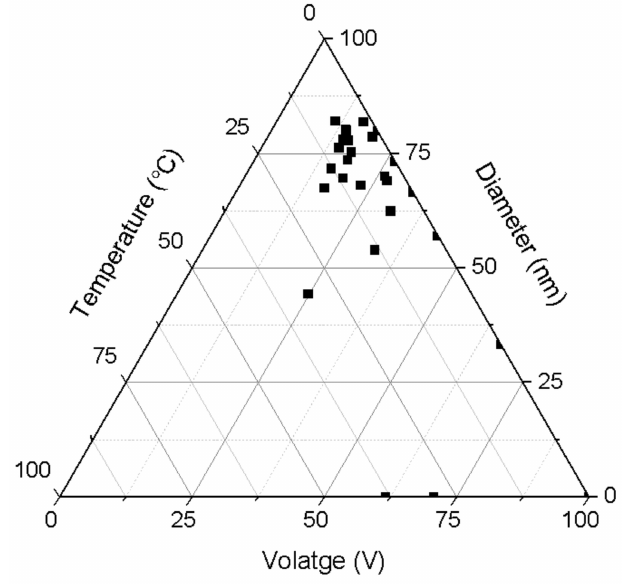
Figure 5. The correlation between the applied voltage, temperature and diameter of nanopores represented as ternary